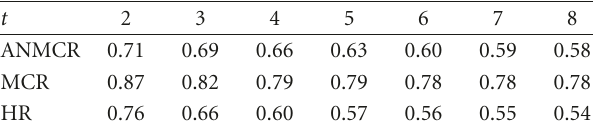
Table 4: Normalized residual noise evolution given by the rate (cid:12) σ ( t ) /σ for a realistic synthetic image sequence typical of X-ray exams, processed by the adaptive temporal filter without motion compensation (ANMC), with transparent motion compensation (MC) and by the proposed hybrid filter